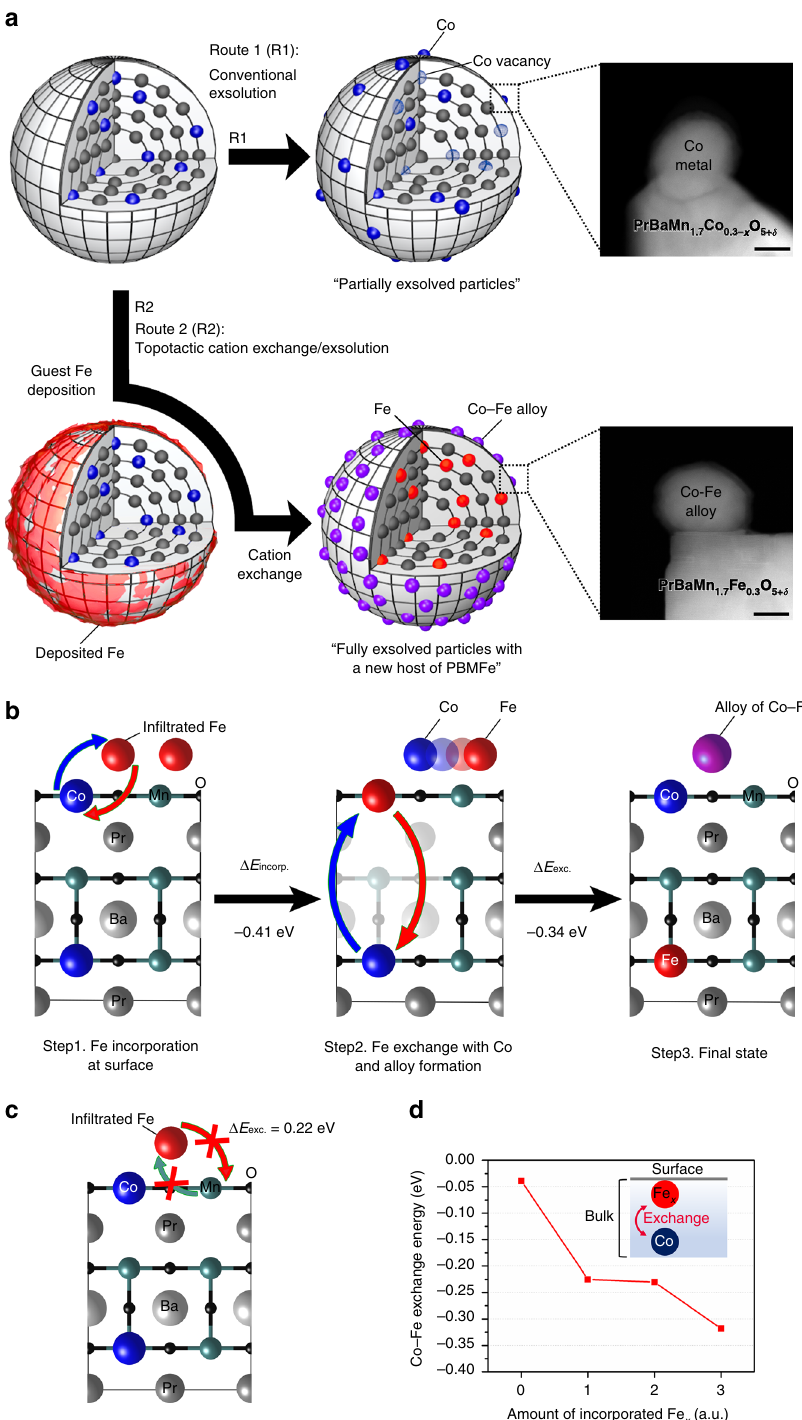
Fig. 1 Schematic of exsolution process and density functional theory calculations. a Exsolution process with and without topotactic ion exchange. b Topotactic ion exchange energetics for the mechanism of particle exsolution via Fe in fi ltration on the PBMCo surface. c The unfavorable incorporation energy of in fi ltrated Fe with Mn of the top surface. d Calculated energetics for the Co – Fe x exchange depending on arbitrary Fe